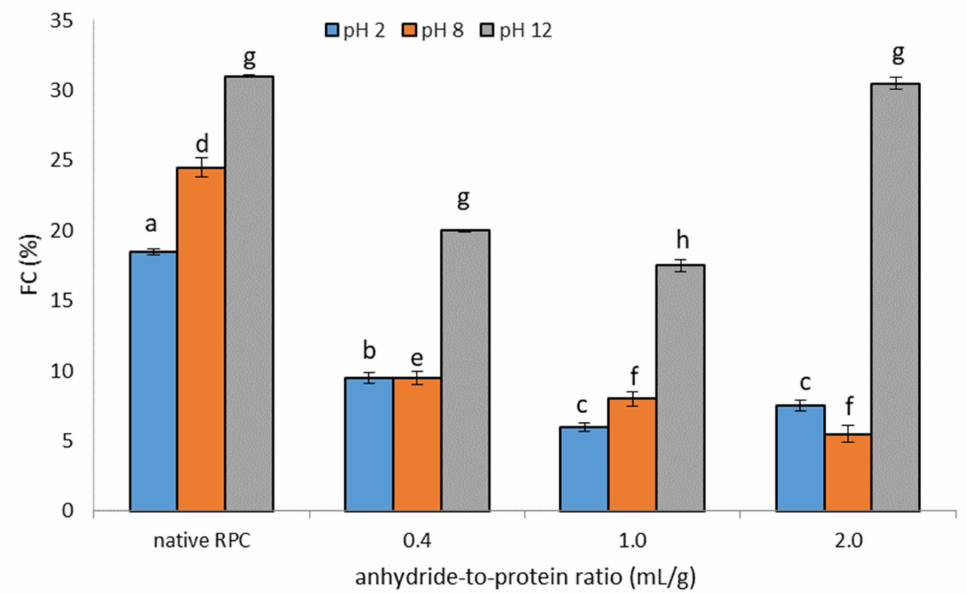
Figure 3. Effect of anhydride-to-protein ratio on foam capacity (FC) at different pH of native and acetylated RPC. a, b, c—the same letters within the pH 2 indicate values that are not significantly different; d, e, f—the same letters within the pH 8 indicate values that are not significantly different; g, h—the same letters within the pH 12 indicate values that are not significantly different. PRC—rice protein concentrate; 0.4, 1.0, 2.0—rice protein preparations after acetylation conducted with different concentrations of acetic anhydride